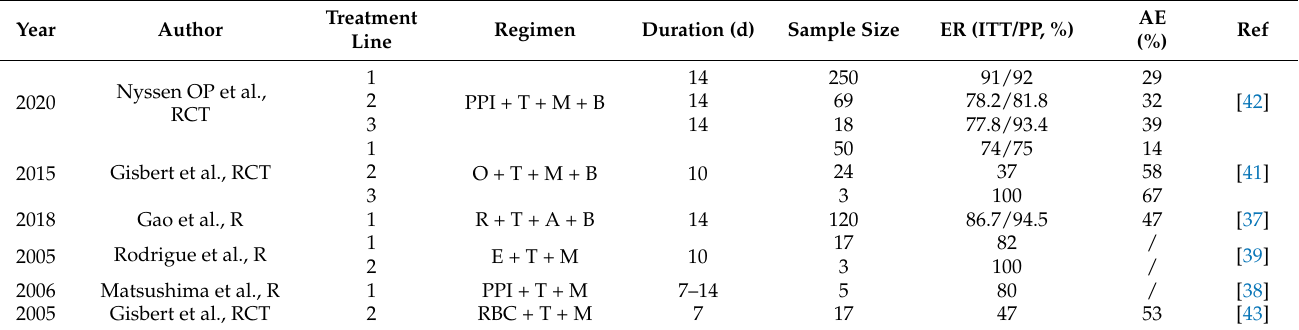
Table 2. Summary of studies with tetracycline-containing regimens in patients with penicillin allergy.